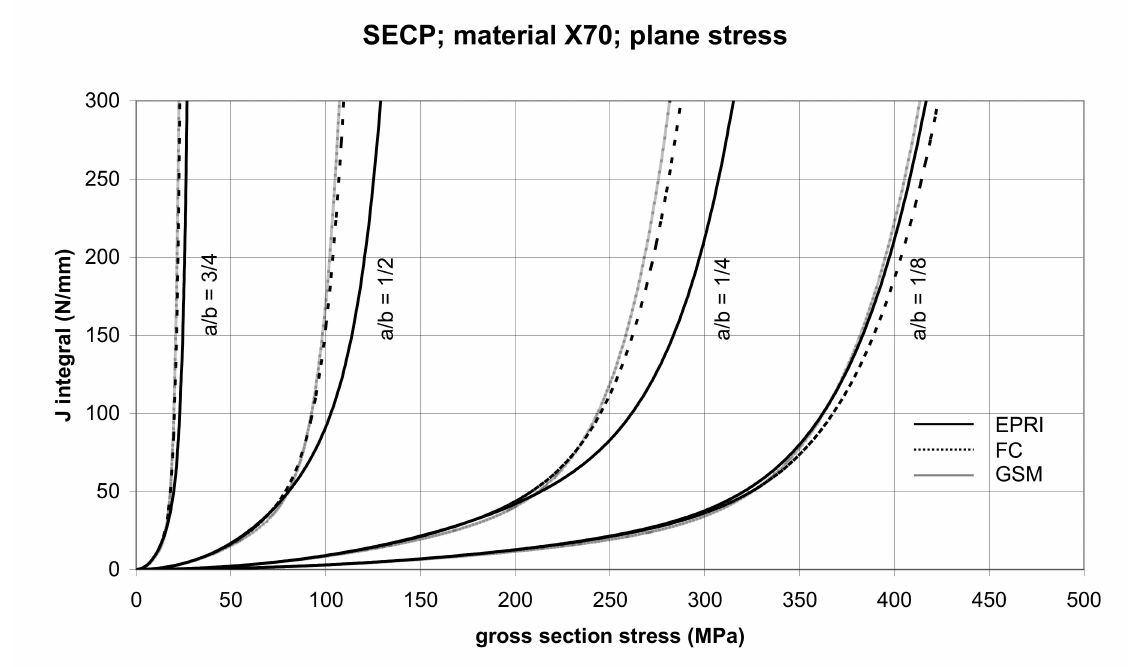
Figure 16. Comparison of J integral for SECP X70 steel specimens in the plane stress condition as determined by the EPRI, GSM, and FC methods.